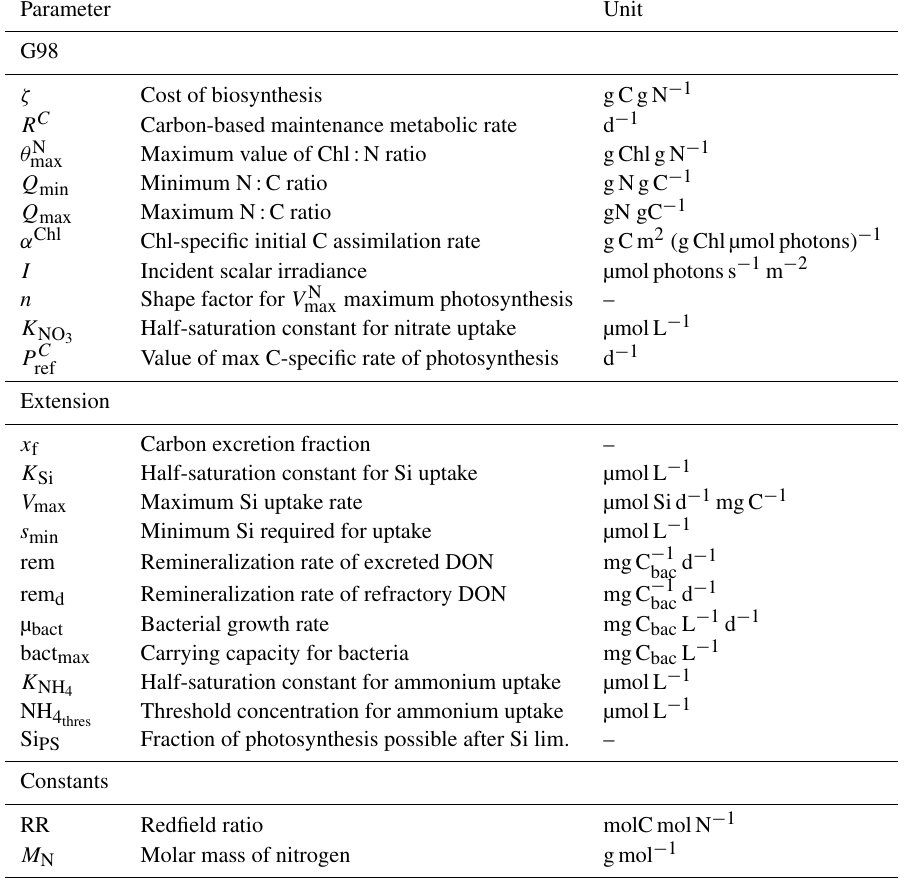
Table A2. Parameters of the original G98 model and the model extension with associated units.